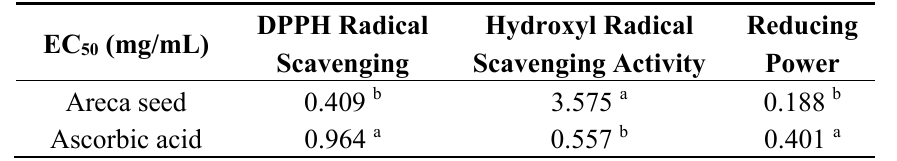
Table 3. Correlations established between the concentration of extracts with antioxidant activity EC 50 values.